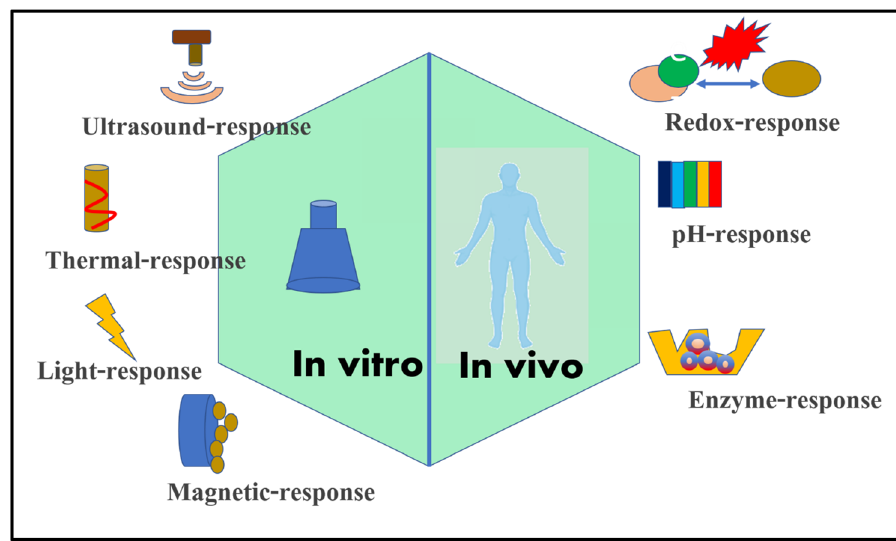
Figure 2: Schematic sketches of di ff erent types of stimuli for cancer